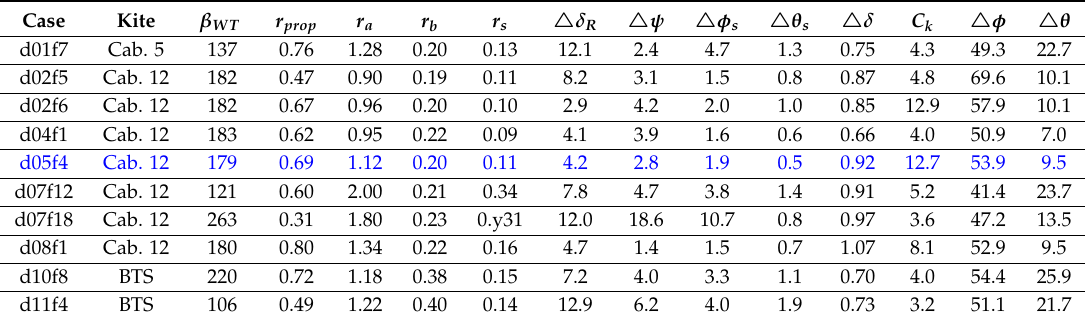
Table 3. Relevant quantities taken out from the ten runs suitable with the phase-averaging method. Angles are given in degrees, and the steering amplitude is given in meter. The blue line denote the case which is plotted in Figures 11 and 18. Additional data is available in Appendix